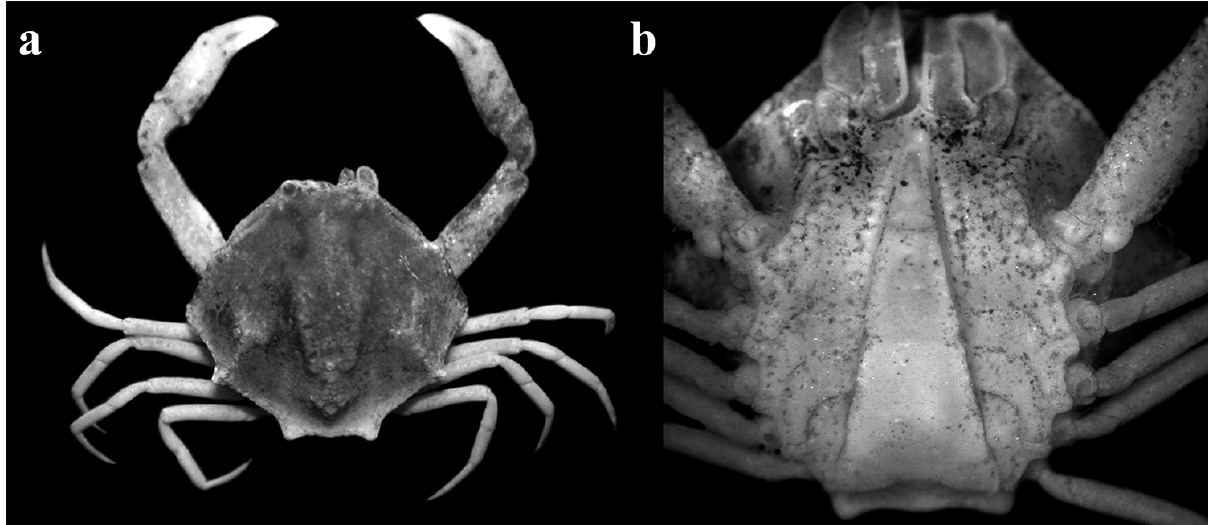
Figure 6. Bellayra nishihirai gen. nov., comb. nov., male (CL 5.9 mm, CB 6.3 mm) (ZRC 2002.602). a , Habitus, dorsal view; b , ventral